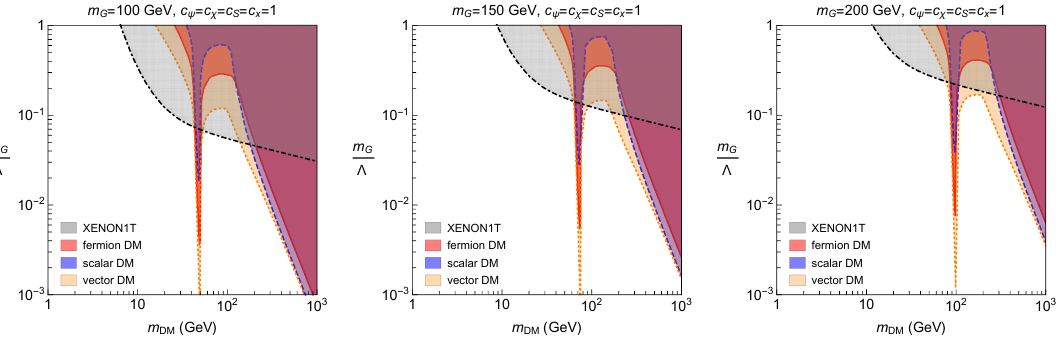
Figure 6 . Parameter space of fermion and scalar dark matter in m DM vs m G = (cid:3). The gray regions are excluded by XENON1T. We took c (cid:31) = c S = c u;d;s;c;b;t = 1 and m G = 100 ; 150 ; 200 GeV on left, middle and right, respectively.